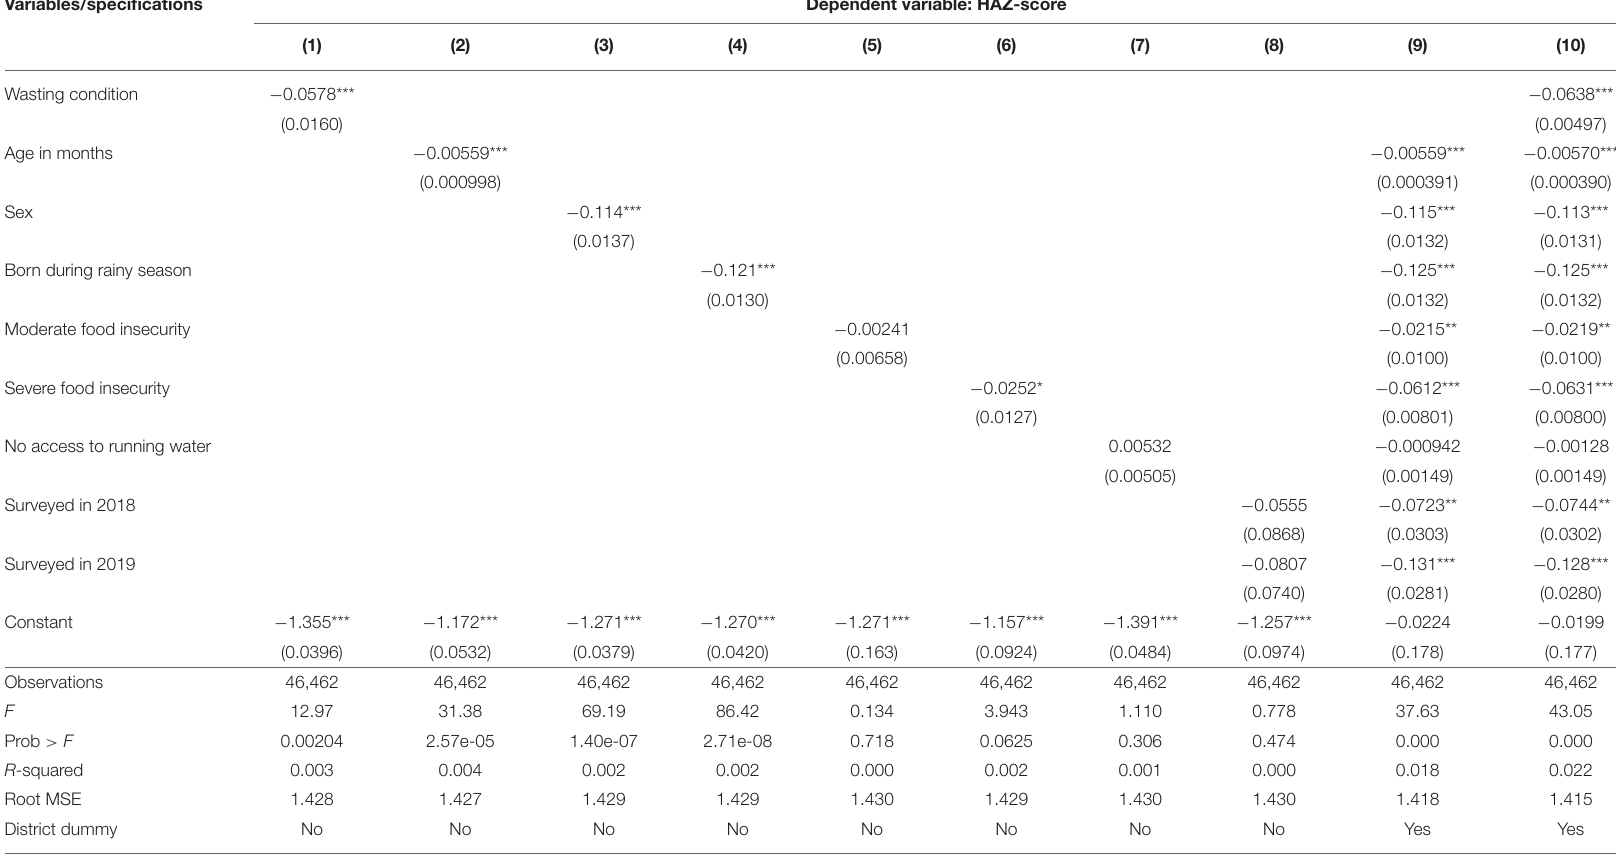
TABLE 8 | Linear regression models for the height-for-age